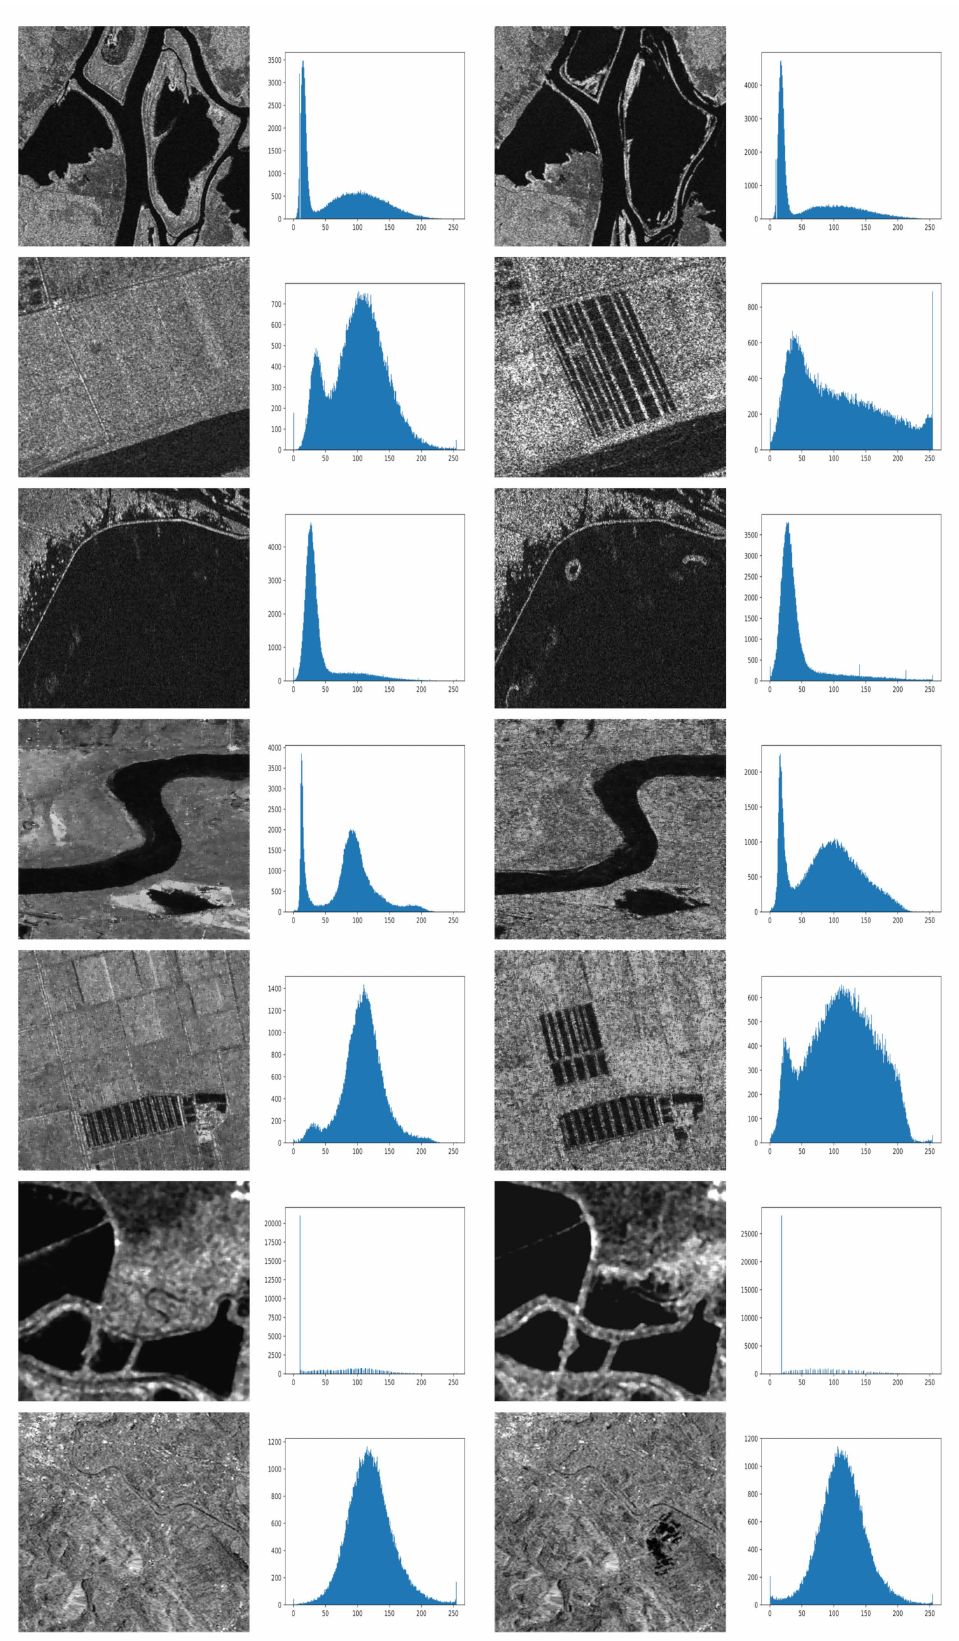
Figure 2. Image pairs and their